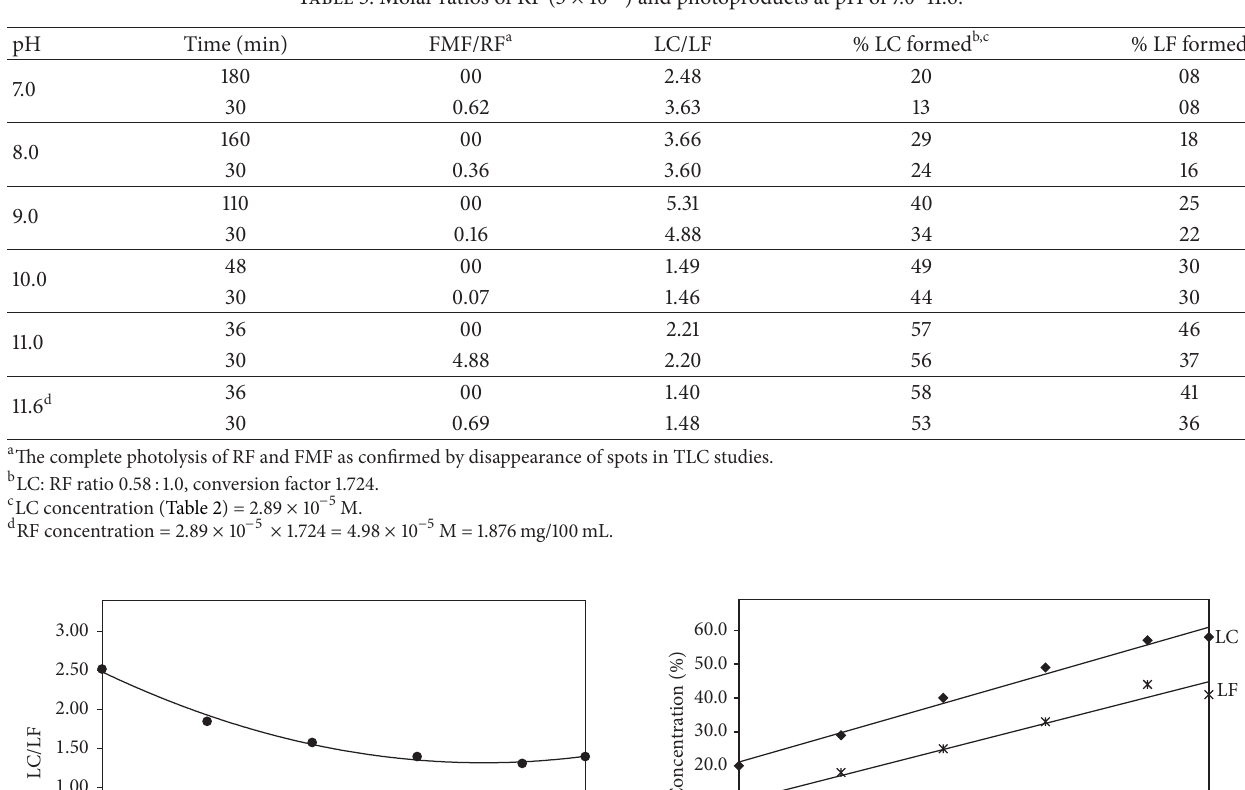
Table 3: Molar ratios of RF (5 × 10 − 5 ) and photoproducts at pH of 7.0–11.6.